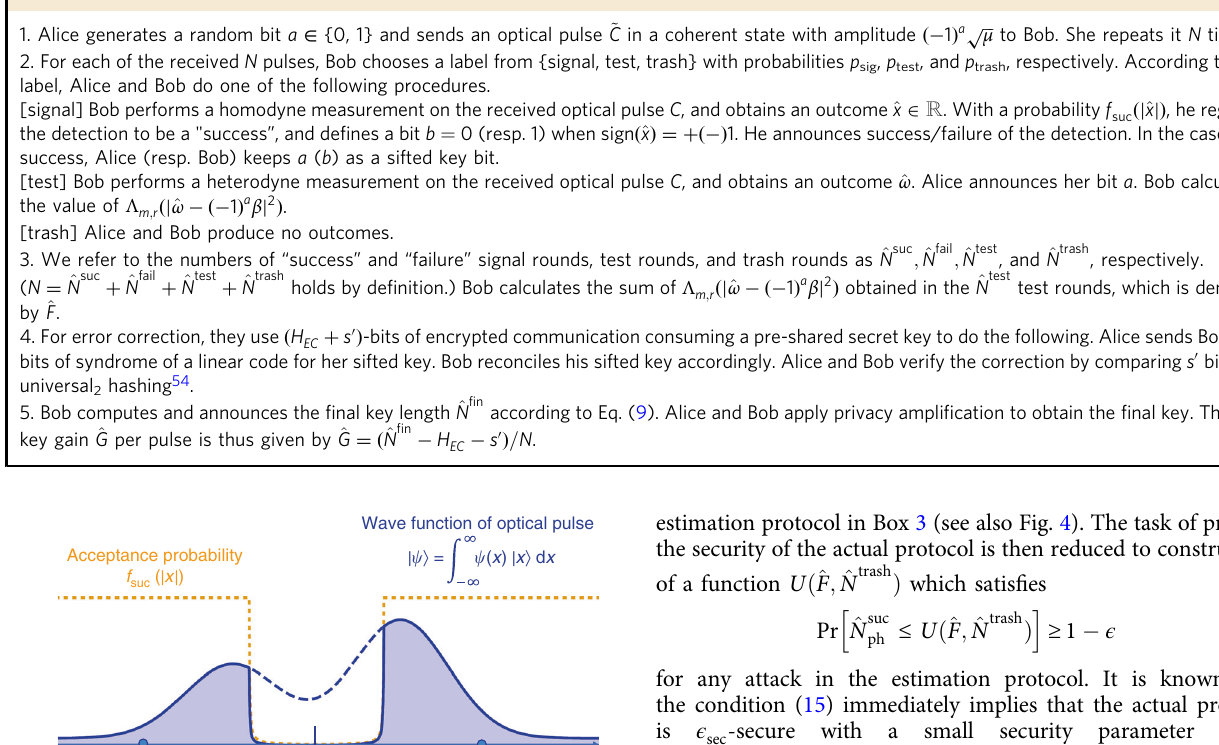
ffiffiffiffiffiffiffiffiffiffiffiffiffiffiffi p ϵ þ 2 (cid:2) s